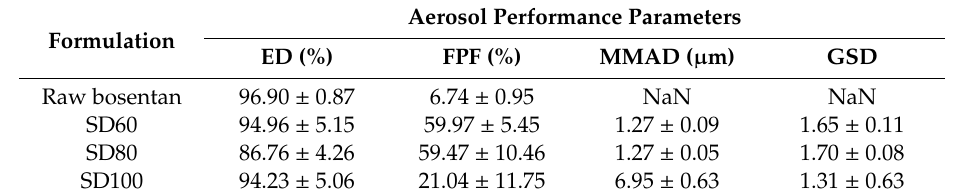
Table 4. Aerosol performance parameters of raw BST and spray-dried BST microparticles (mean ± standard deviation, n = 3).